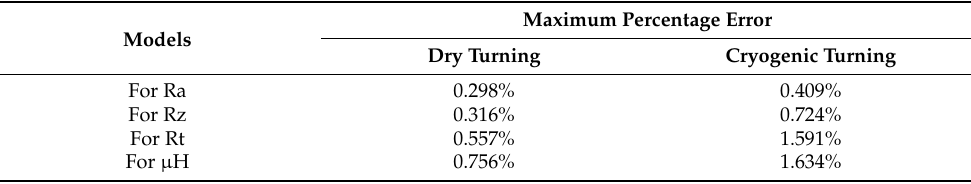
Table 8. Maximum percentage error between predicted and experimental values for the models developed for the surface roughness and micro-hardness of the AZ31C magnesium alloy.